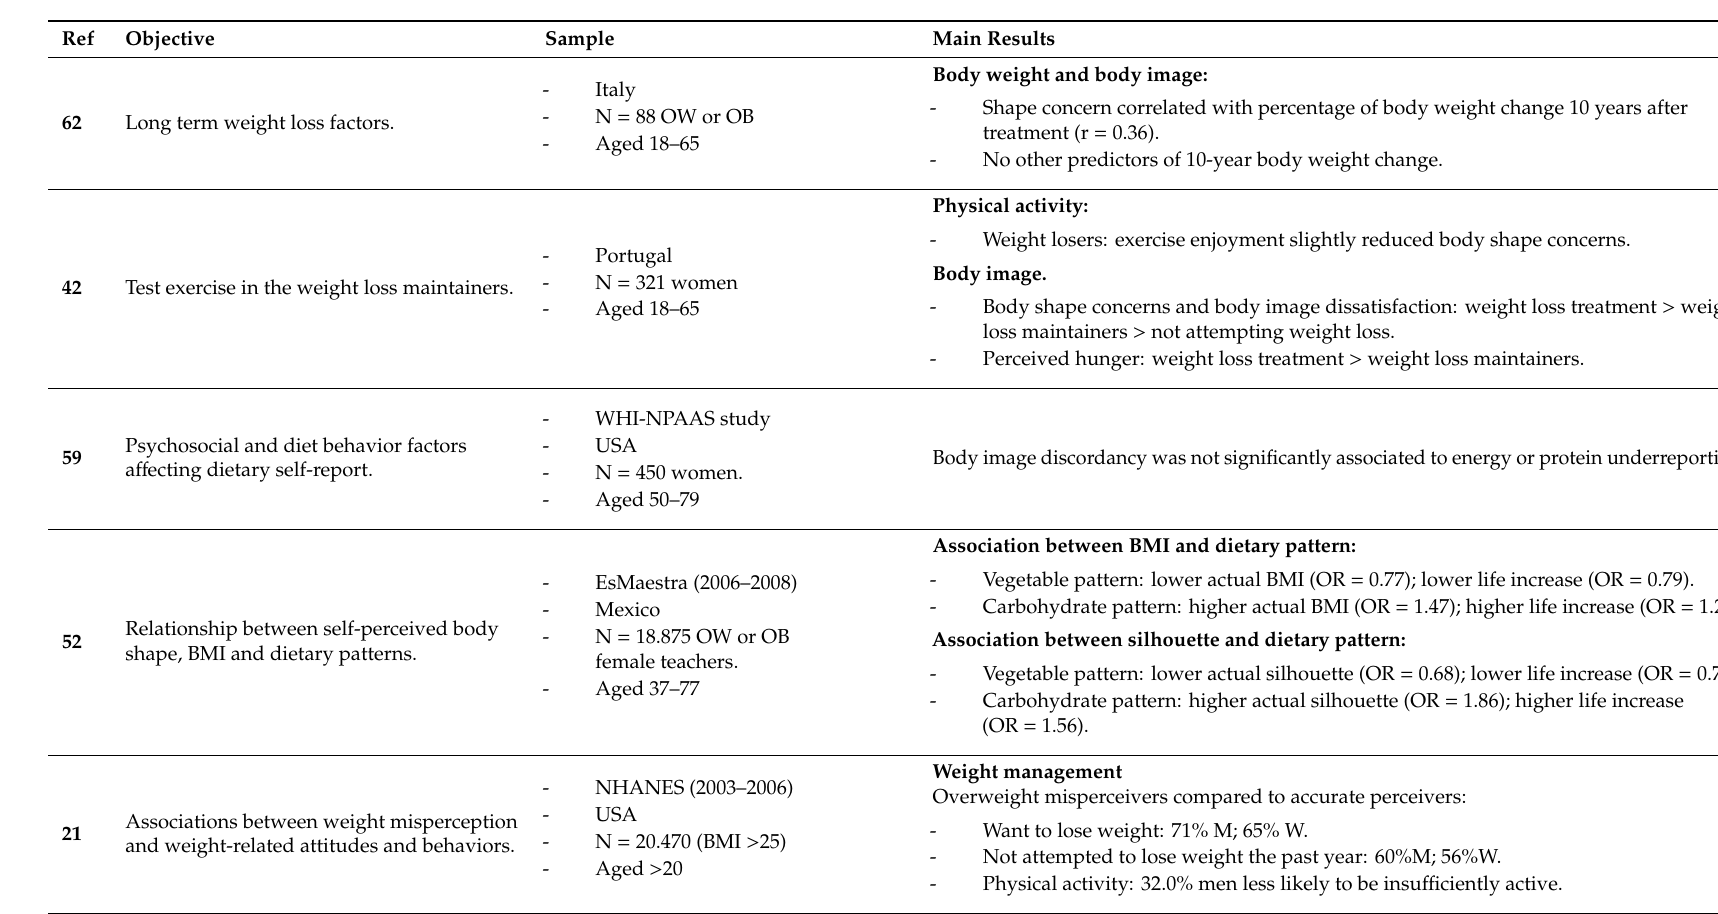
Main Results Body weight and body image: - Shape concern correlated with percentage of body weight change 10 years after treatment (r = 0.36). - No other predictors of 10-year body weight change. Physical activity: - Weight losers: exercise enjoyment slightly reduced body shape concerns. Body image. - Body shape concerns and body image dissatisfaction: weight loss treatment > weight loss maintainers > not attempting weight loss. - Perceived hunger: weight loss treatment > weight loss maintainers.